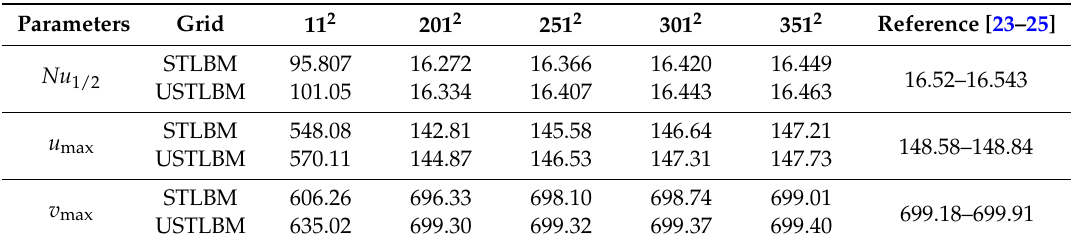
Table 3. Comparisons of flow parameters in Ra = 10 7 at different mesh sizes.